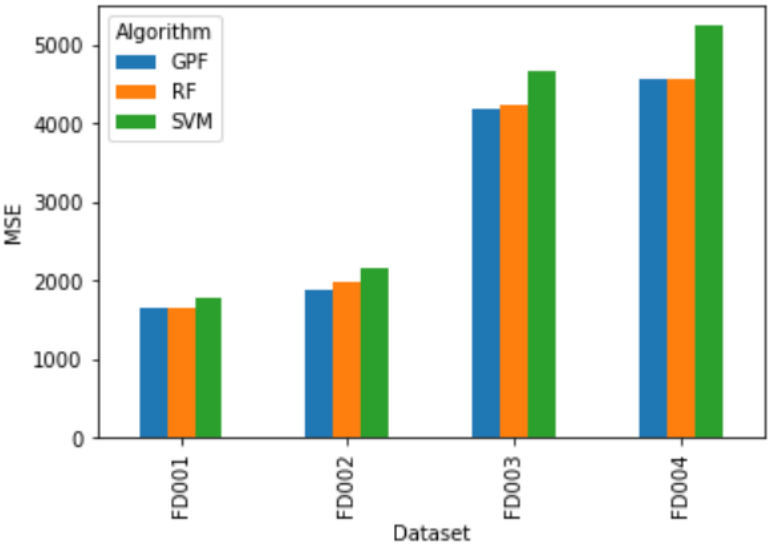
Figure 9. The MSE of GPF versus purely using RF or SVM for the four CMAPSS datasets.